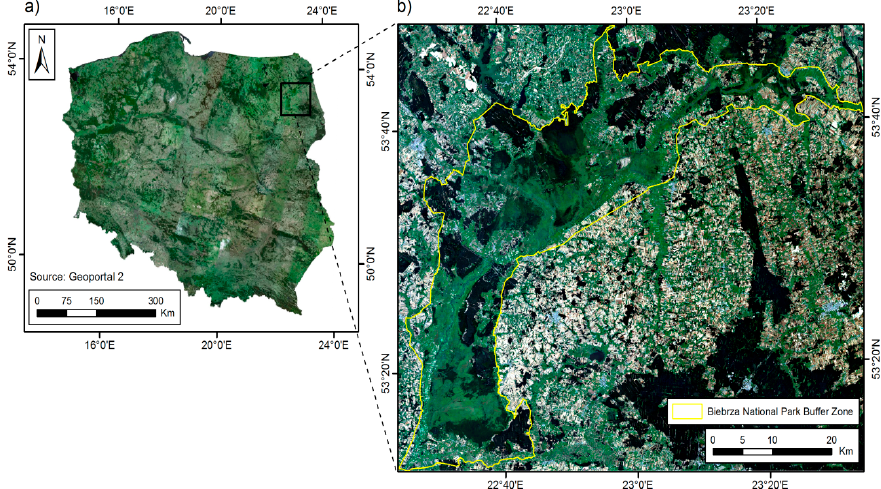
Figure 1. Localisation of the test site in Poland on the orthophotomap ( a ); and the Biebrza Wetland area on the Landsat 8 OLI RGB (4,3,2) image registered on 3 August 2014 ( b ).